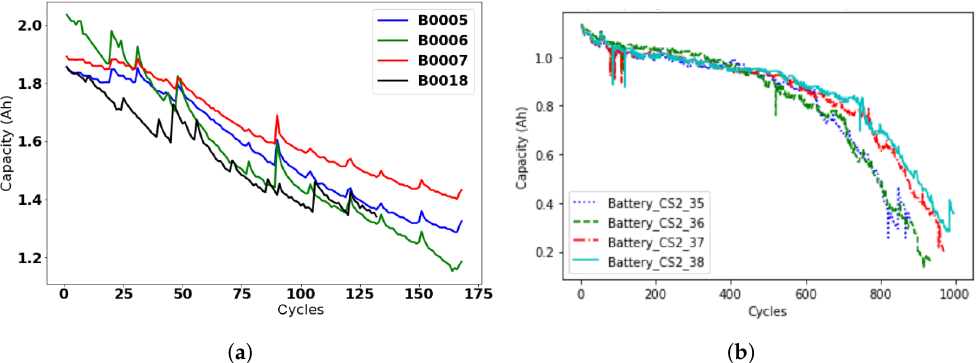
Figure 3. SoH degradation of NASA and CALCE datasets during charge and discharge cycles. ( a ) NASA dataset [22], ( b ) CALCE dataset